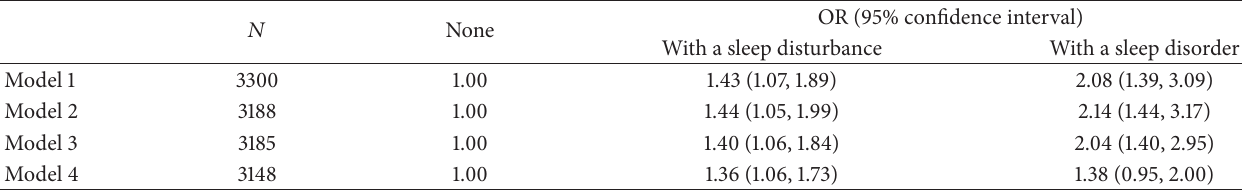
Table 2: Adjusted odds ratio of diabetes for sleep disorder status, NHANES 2009-2010. 𝑁